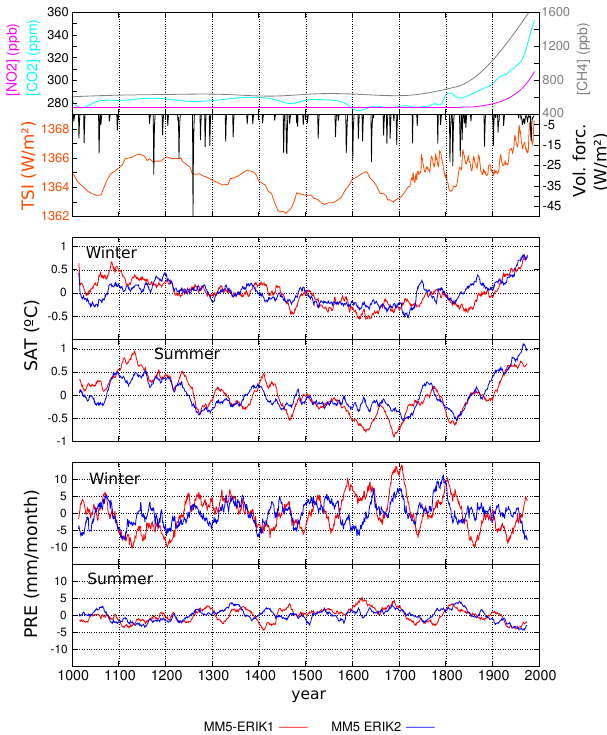
Fig. 1. Evolution of the external forcings (first two panels), spa- tial average of SAT (two middle panels) and PRE (bottom pan- els) anomalies for winter (December–February) and summer (June– August). The MM5-ERIK1 and MM5-ERIK2 experiments are coloured red and blue, respectively. The eight series have been smoothed with a running mean of 31yr, and the same vertical scale has been applied to both seasons to emphasise their different